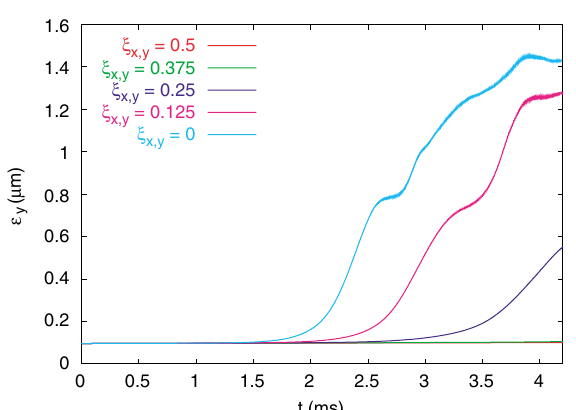
FIG. 15. (Color) Vertical emittance growth over 2000 turns for (cid:1) 8 (cid:2) 10 10 p = b . The bunch has FIG. 13. (Color) Vertical emittance growth over 2000 turns for different bunch lengths and N b (cid:1) 8 (cid:2) 10 10 p = b . This bunch different chromaticities and N been rematched for each case by keeping the longitudinal b intensity is far inside the instability region. emittance constant and changing the synchrotron tune.